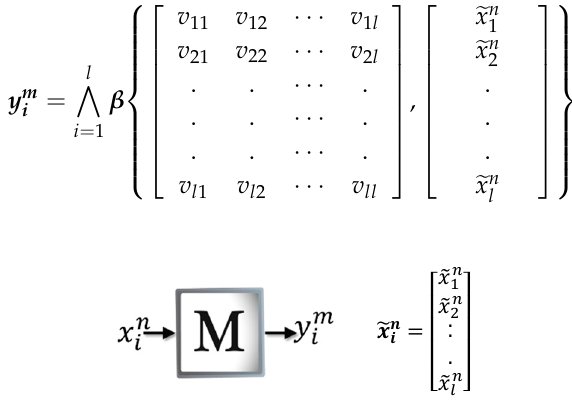
Figure 5. Test phase of the Am αβ .